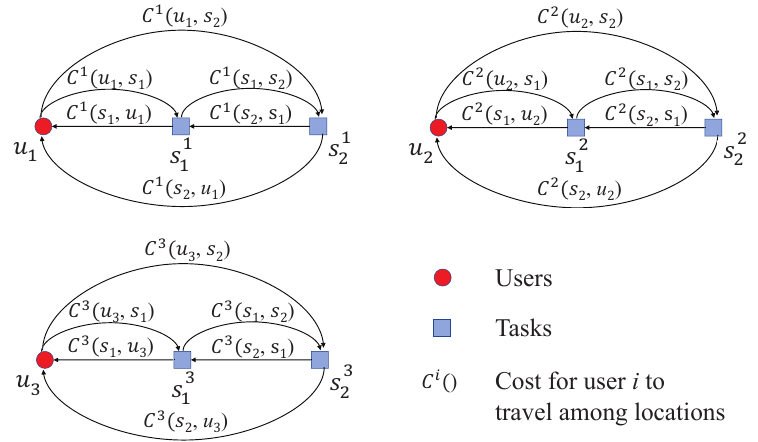
Figure 3. An example of the virtual task locations and costs for 3 users and 2 task